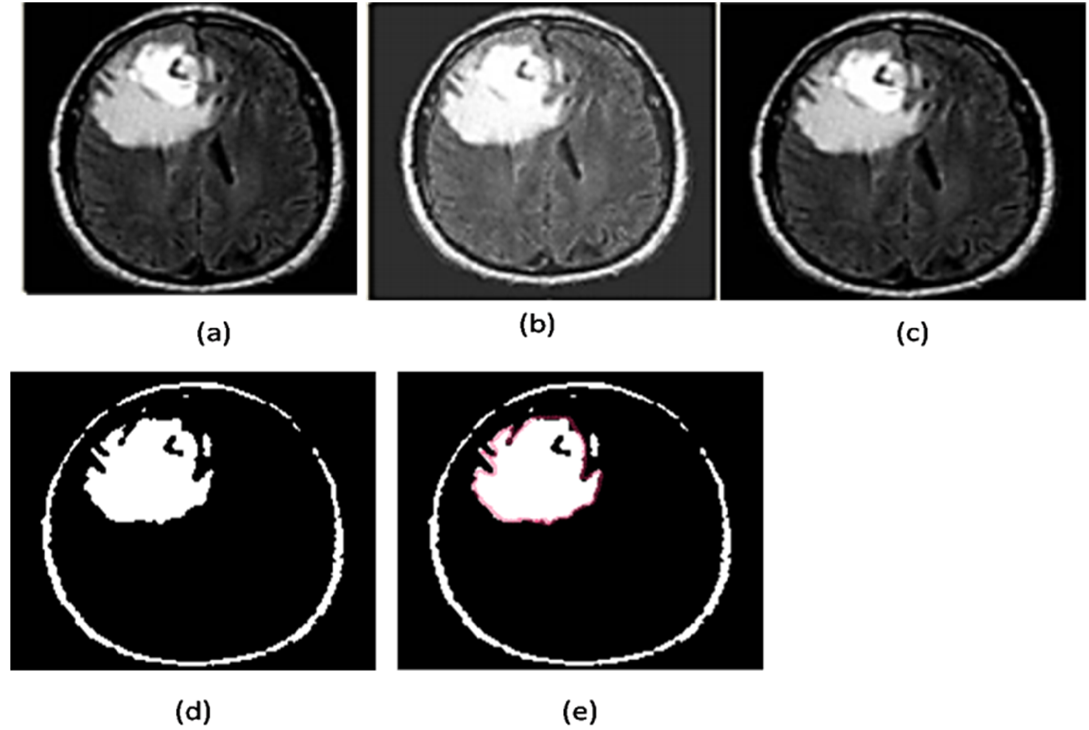
Figure 7. Processing and results of an image from the Rider Neuro dataset. ( a ) Grayscale image; ( b ) segmentation; ( c ) morphological operations; ( d ) ROI selection and coloring; ( e ) differentiated tissue.